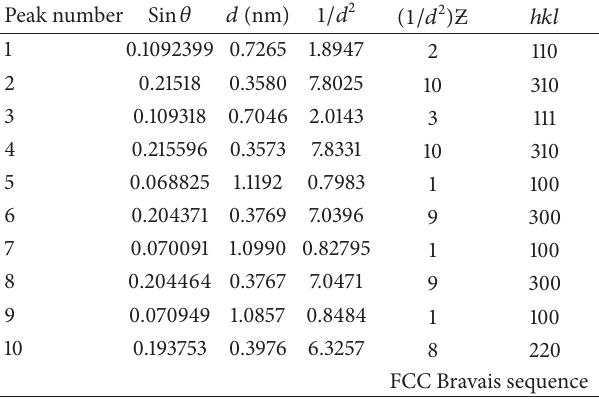
Table 5: Indexing XRD pattern: Bragg’s